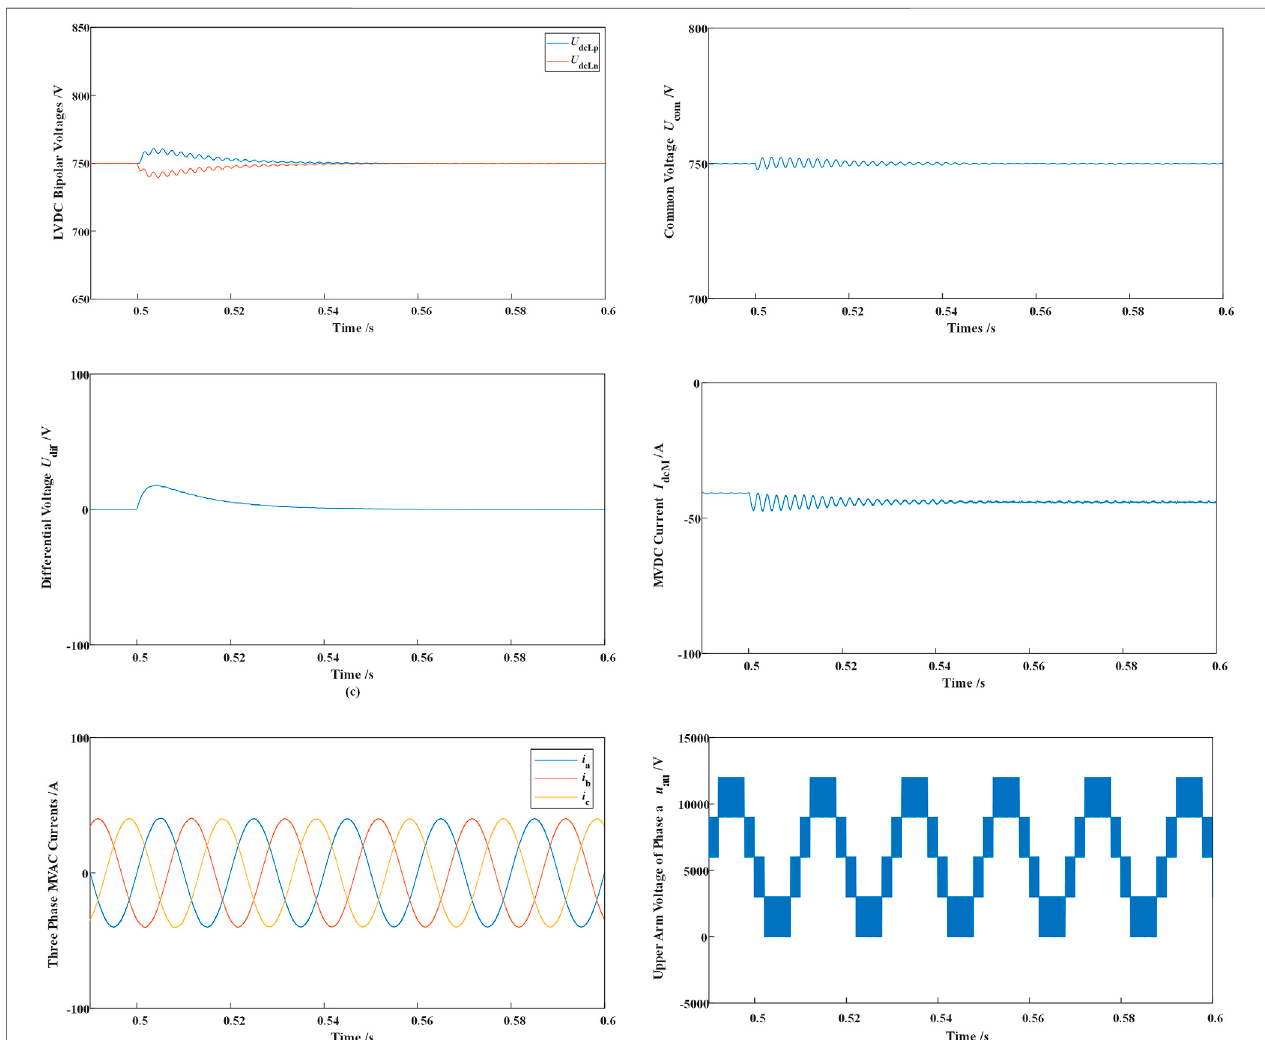
FIGURE 10 | Simulation results of a power imbalance event (LVDC bipolar voltages; LVDC common voltage U com ; LVDC differential voltage U dif ; MVDC current I dcM ; Three-phase MVAC currents i a , i b , and i c ; and upper arm voltage of phase a).